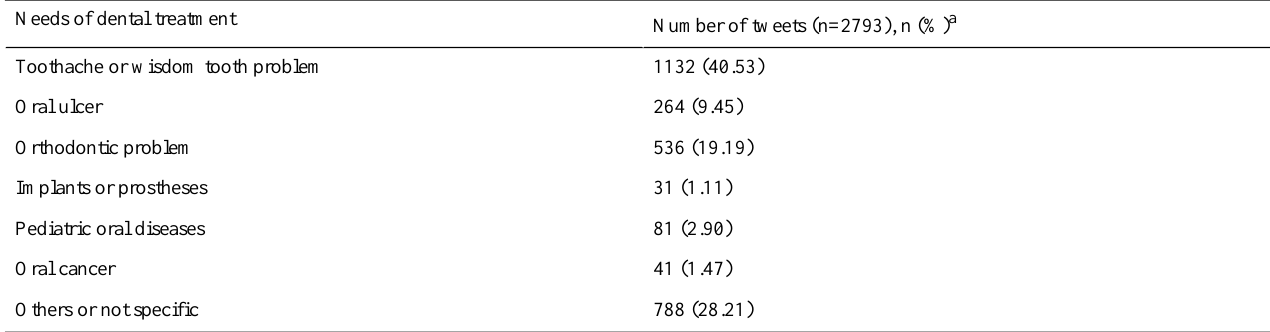
Table 2. Needs for dental treatment during COVID-19